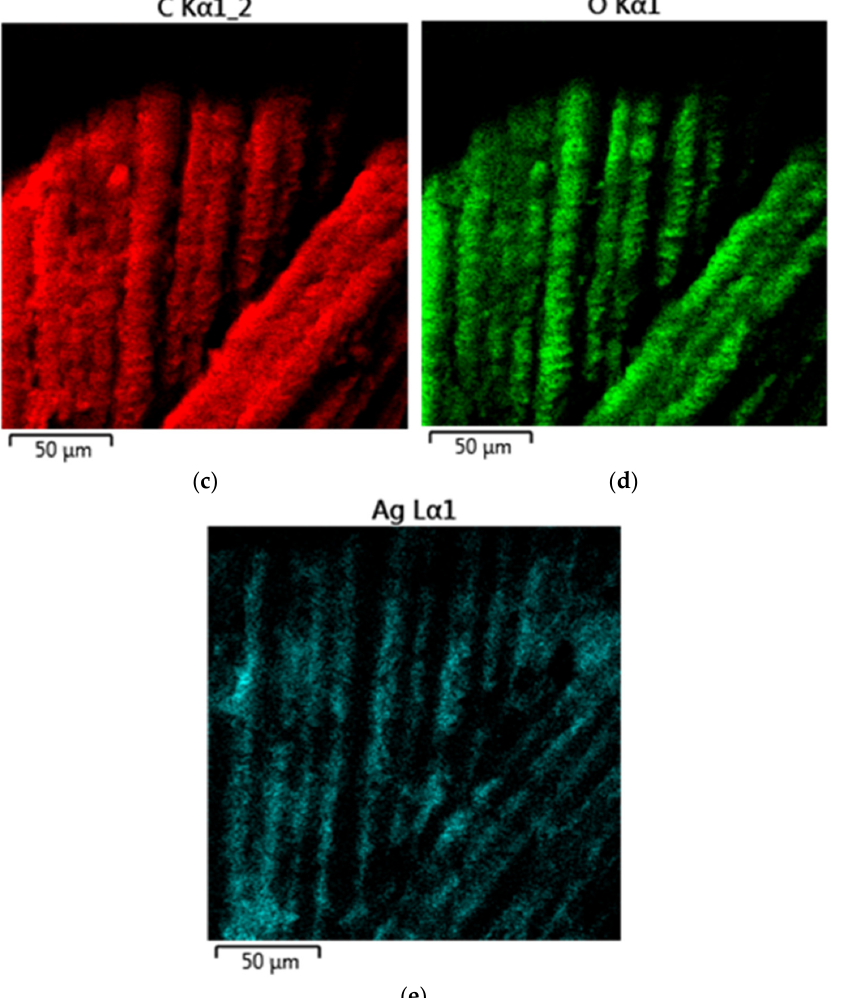
Figure 19. A sample of suture material treated by Ag NPs: ( a )—SEM micrograph, ( b )—multilayer map of EDS, ( c )—elemental map of EDS (C), ( d )—elemental map of EDS (O) and ( e )—elemental map of EDS (Ag).